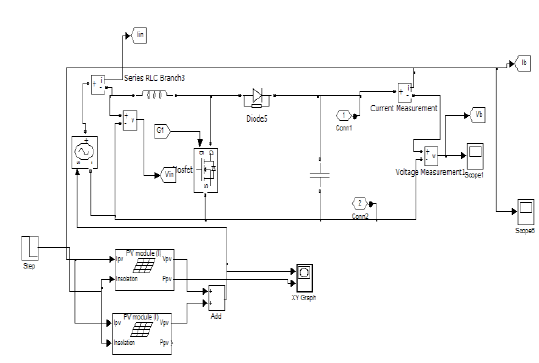
Figure 13 . A Sub-system of MPPT Boost Converter The sub-system of the seven-level CHB circuit is intended in figure 12. The MPPT Boost converter as the designed 7-level inverter is illuminated in figure 13. The output Figure 10 . Fuzzy Rule Viewer for Closed-Loop was switching pulses for switches S a to S f , as shown in System figure 14.